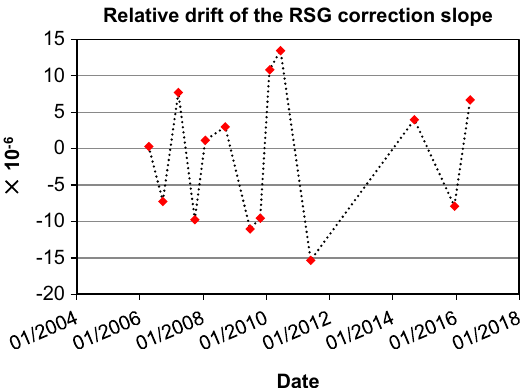
Fig. 3. Relative drift in the slope correction coef fi cient of the RSG between a current calibration and the previous one.